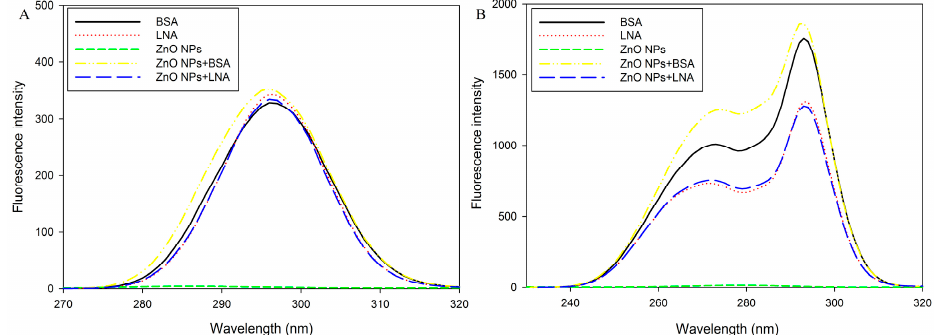
Figure 5. Synchronous fluorescence spectra of bovine serum albumin (BSA), α -linolenic acid (LNA; complexed to BSA; referred as LNA) and ZnO NPs (code: XFI06) suspended in distilled and deionized water (DDW), 0.5% BSA, or 200 µM LNA. ( A ) Δλ = 15 nm; ( B ) Δλ = 60 nm.